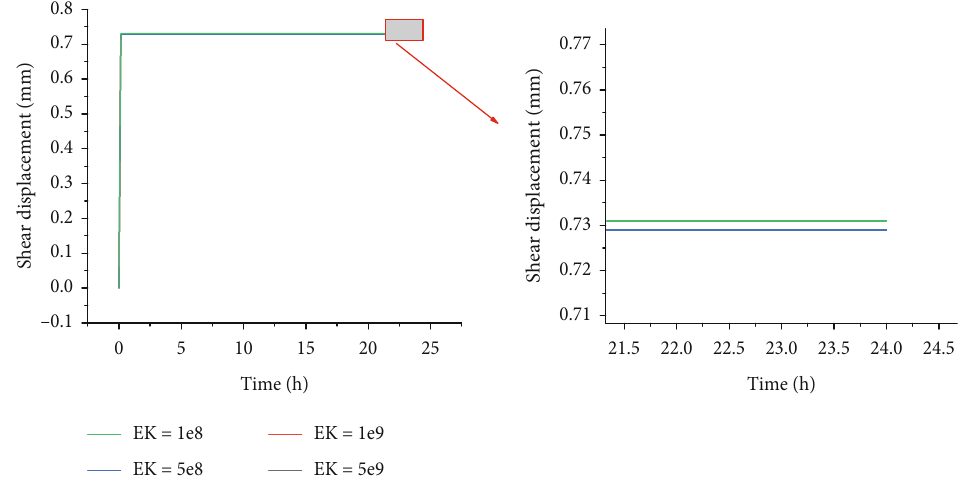
Figure 9: Shear displacement-time relation under di ff erent E